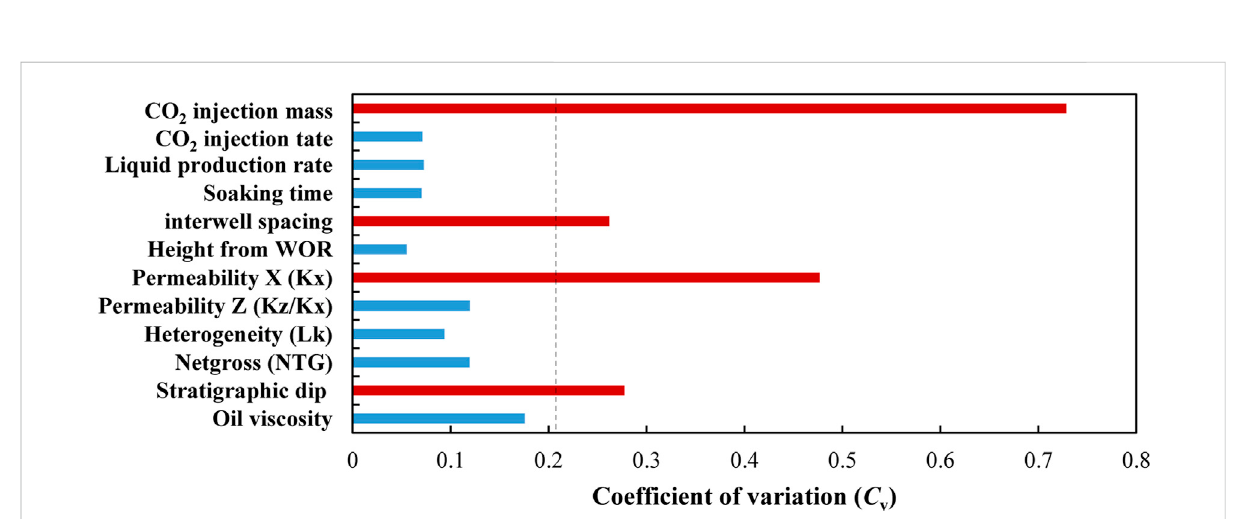
FIGURE 10 Sensitivity analysis results of the well-to-well interplay during the CO 2 huff-n-puff process.